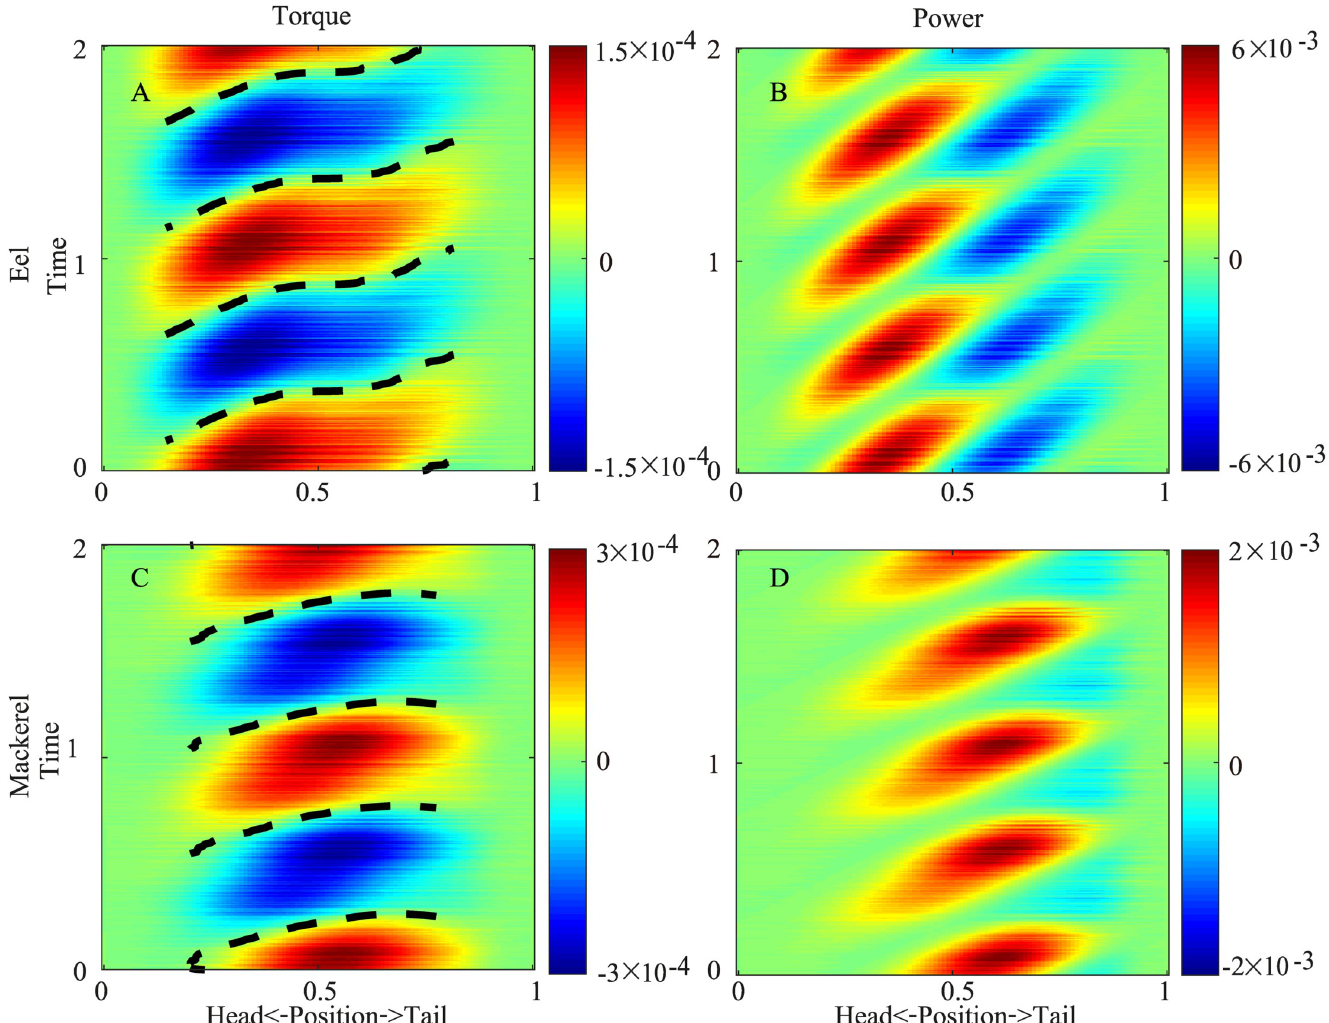
Fig 7. Torque (A) and power (B) distributions when the elasticity of the body is considered for the eel and torque (C) and power (D) distributions for the mackerel. The dashed lines indicate zero-crossings of the torque.